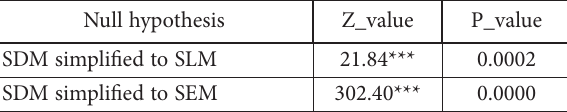
Table 5. LR test results